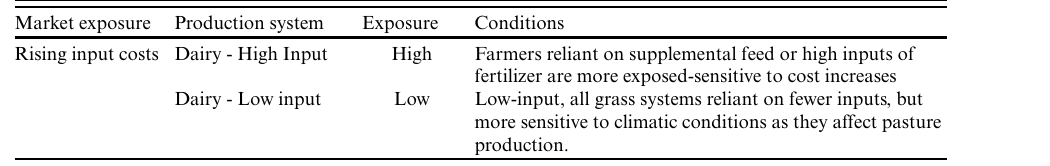
Table 6 . Differences in exposure to input costs (Source: Research